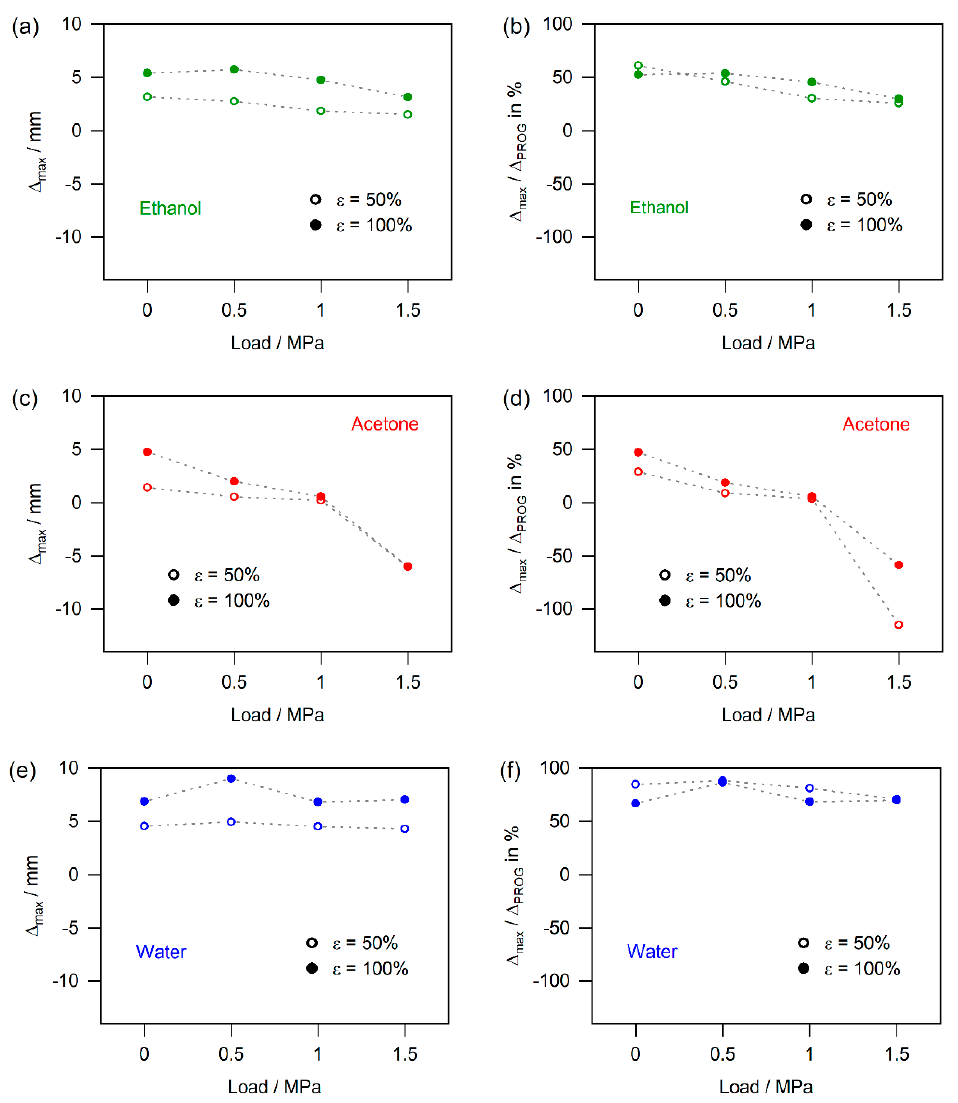
Figure 12. Effect of end loads on actuation. Stresses of 0 (i.e., unconstrained recovery), 0.5, 1.0, and 1.5 MPa are considered. ( a , c , e ) Stroke ∆ max as a function of loading stress. ( b , d , f ) Percentage of recovered programming strain as a function of loading stress. ( a , b ) Ethanol (data points represent the positions which are highlighted by the black arrows in Figure 7). ( c , d ) Acetone (where local maxima are observed: coordinates of maximum are presented; in the absence of maxima, 99% of the end value is given). ( e , f ) Water (99% of the end value is shown).